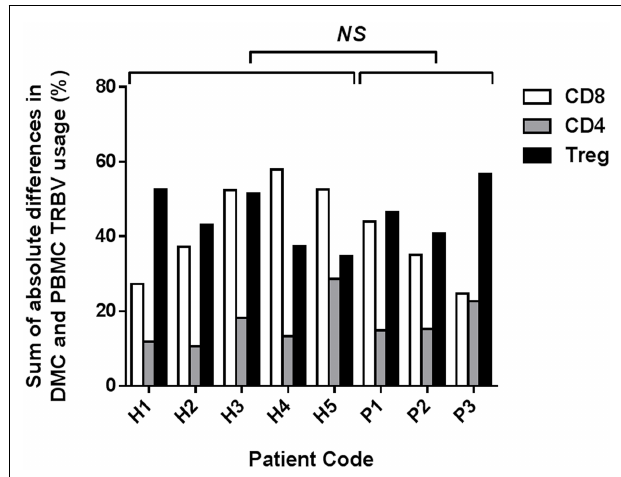
FIGURE 2 | Sum of absolute differences betweenTRBV usage of CD8 + , CD4 + , andTreg subsets in DMC and PBMC . For each patient, the percentage of the identified repertoire represented by eachTRBV subgroup in DMC subsets was compared with that ofT cell subsets within PBMC. The sum of the absolute differences inTRBV frequency for all 25 subgroups analyzed was calculated, for eachT cell subset, to determine the total difference between repertoires ofT cells from DMC and PBMC. No significant difference (NS) was found between healthy and pre-eclamptic patients, for anyT cell subset (Student’s t